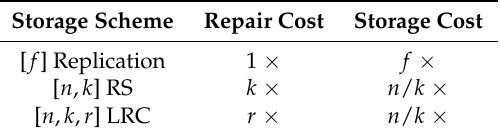
Table 2. Comparisons of Replication, RS Codes and